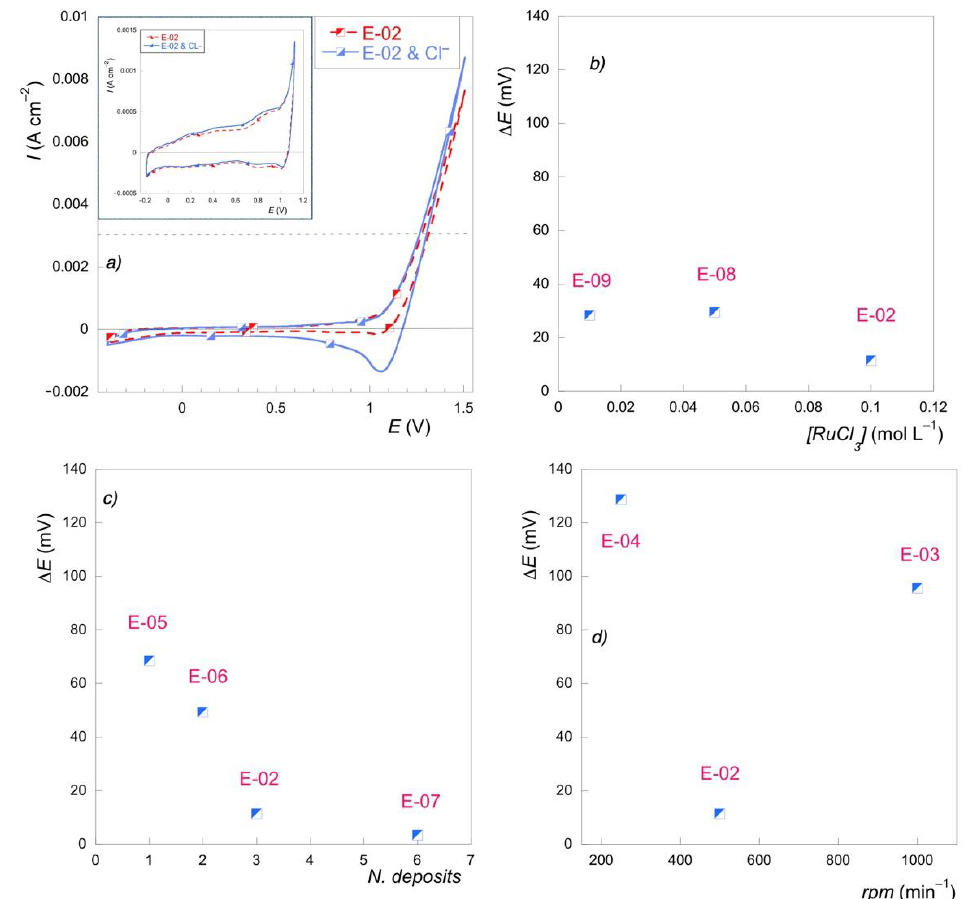
Figure 6. ( a ) Cyclic voltammetry for E-02 with Na 2 SO 4 0.1 M (dot line) and with NaCl 0.1 M (solid line); ( b ) [ ∆ E(V) = E (Na2SO4) − E (NaCl) ] @ 3 mA · cm − 1 vs. precursor concentration; ( c ) [ ∆ E(V) = E (Na2SO4) − E (NaCl) ] @ 3 mA · cm − 1 vs. number of deposits; ( d ) [ ∆ E(V) = E (Na2SO4) − E (NaCl) ] @ 3 mA · cm − 1 vs. spin